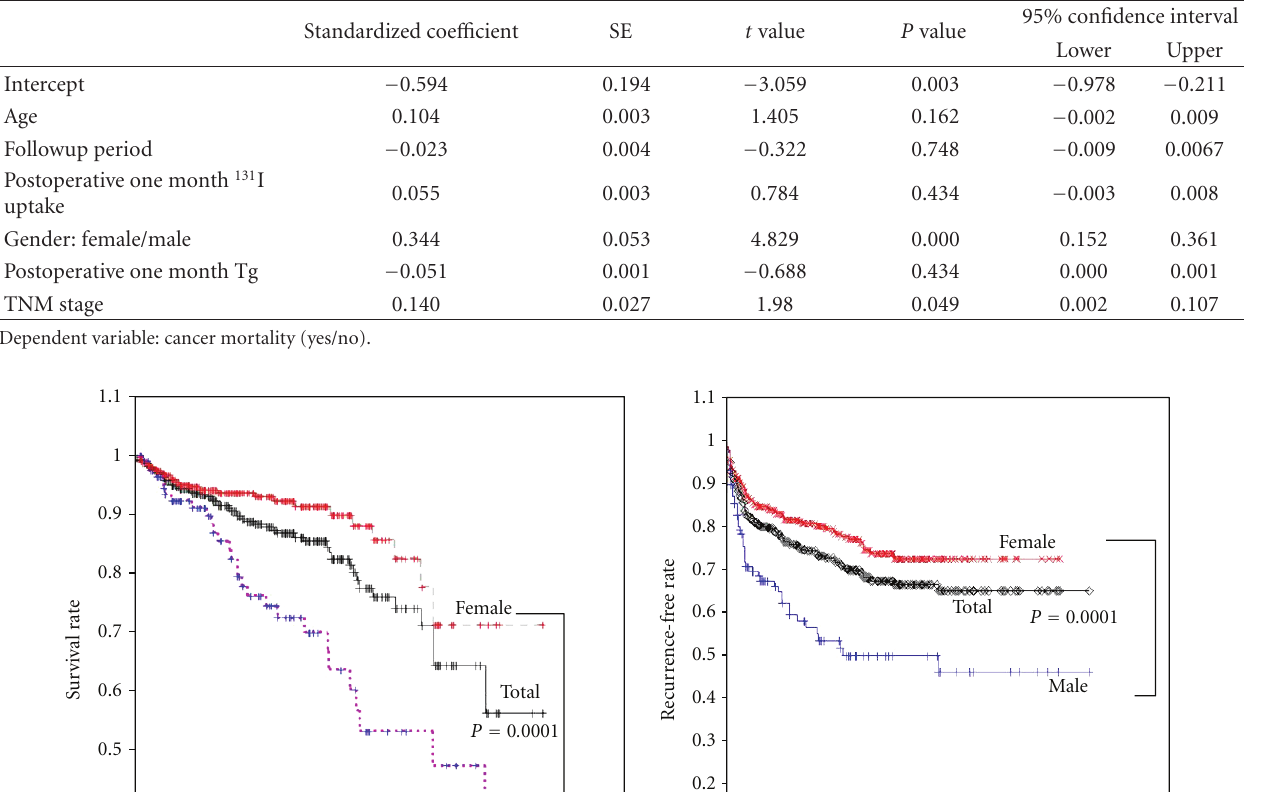
Table 3: Multiple regression analysis for factors associated with cancer mortality.